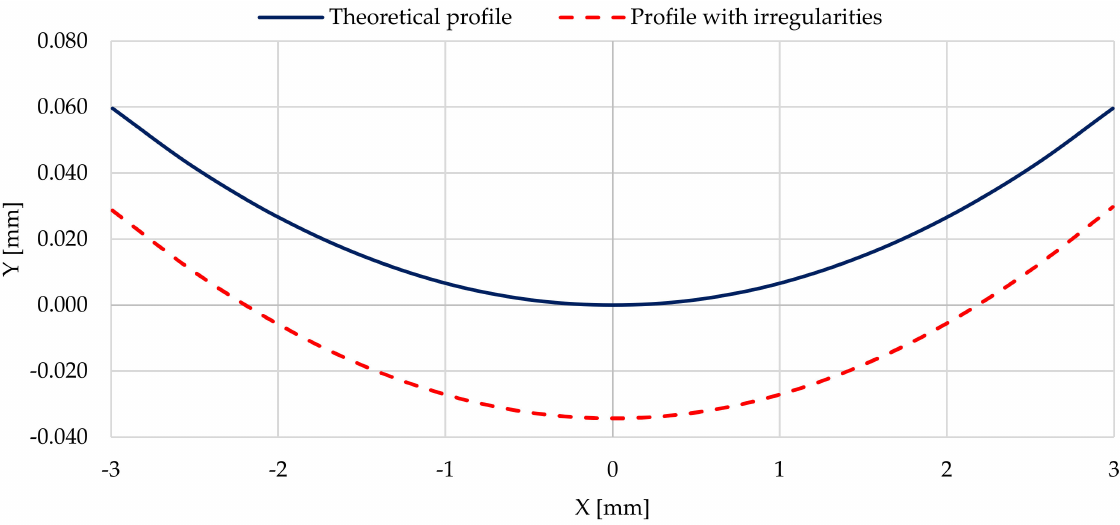
Figure 16. Profiles: not burdened with irregularities and actual one around coordinate x = 200 mm (from Figure 15), transformed into coordinate x =